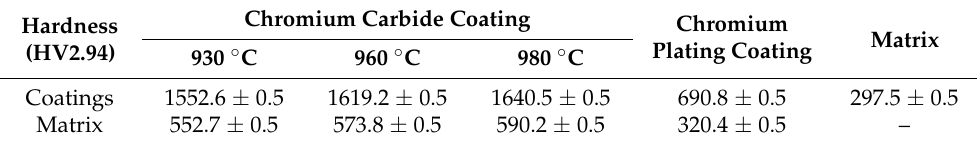
Table 5. Average hardness of chromium carbide specimens with different salt bath temperatures and chromium plating specimens.